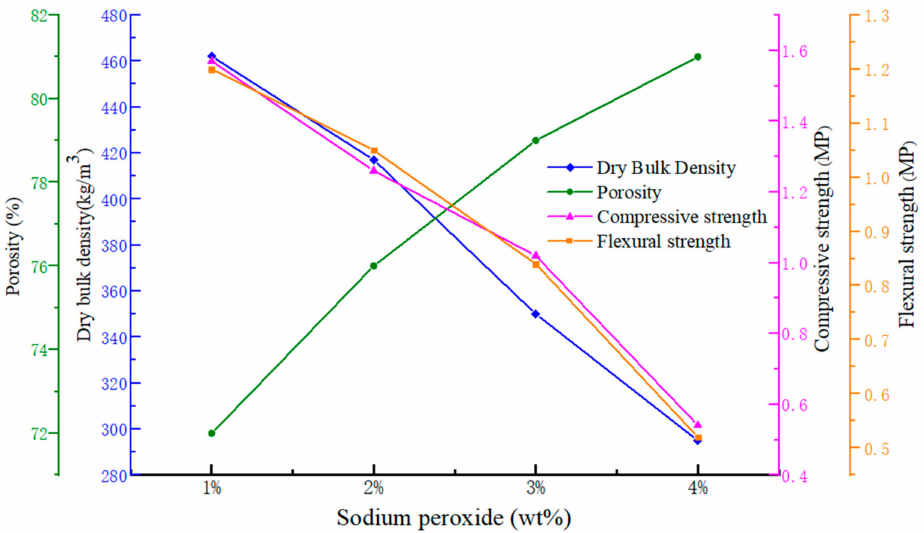
Figure 2. The trend of dry bulk density, porosity, compressive strength and flexural strength versus the mass fraction of Na 2 O